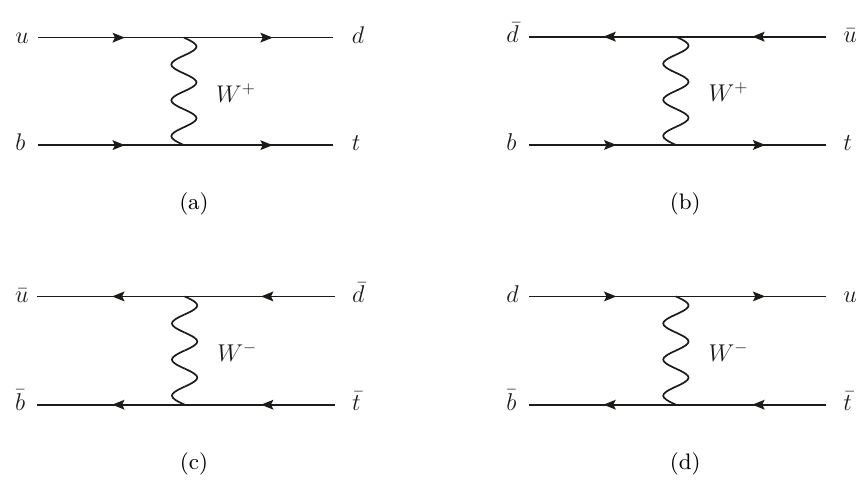
Figure 1 . Feynman diagrams for the processes contributing to t -channel single-top-quark produc- tion at LO, in the five-flavour scheme. In the dominant subprocess, an up- or down-type quark from one of the colliding protons interacts with a bottom quark or antiquark from the other proton by exchanging a virtual W boson to produce a (a) top quark or (d) top antiquark. In the subdominant subprocess, a down- or up-type antiquark from one of the colliding protons interacts with a bottom quark or antiquark from another proton by exchanging a virtual W boson to produce a (b) top quark or (c) top